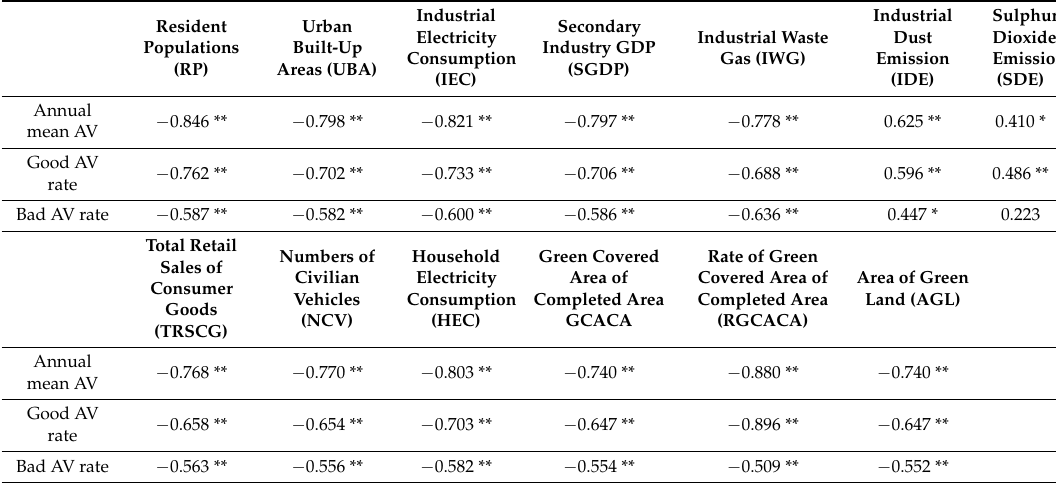
Table 3. Pearson correlation of indicators selected in the